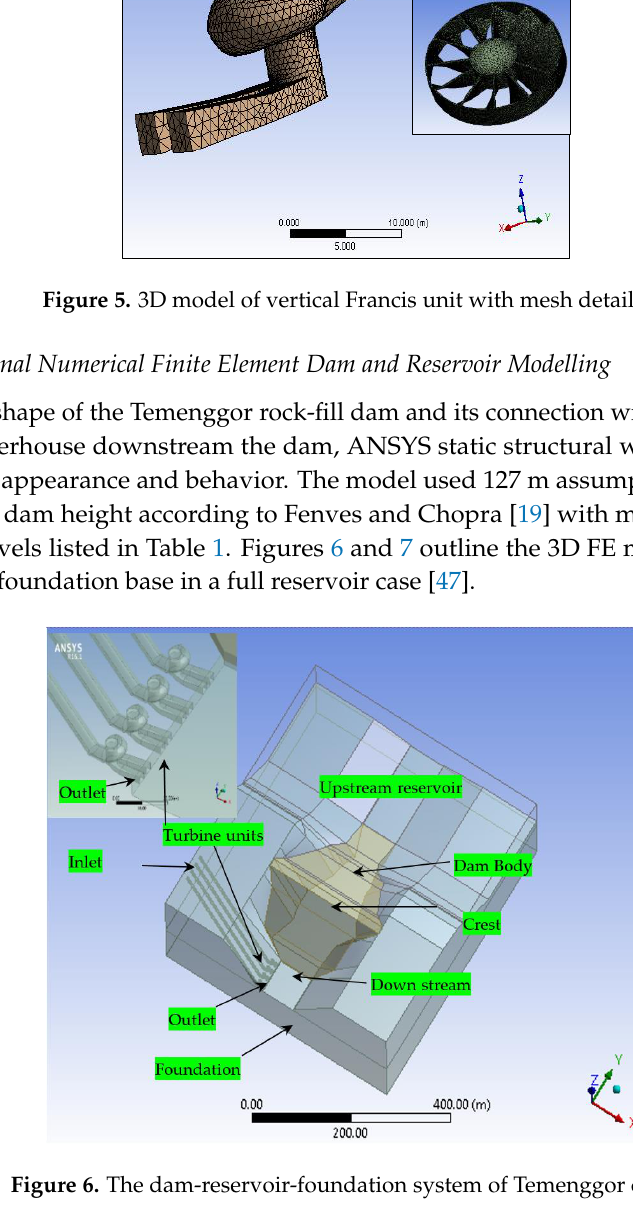
Figure 7. 3D Finite element model of the Temenggor dam rock-bed and full reservoir. 4. Hydraulic Analysis of Turbine Unit and Boundary Conditions